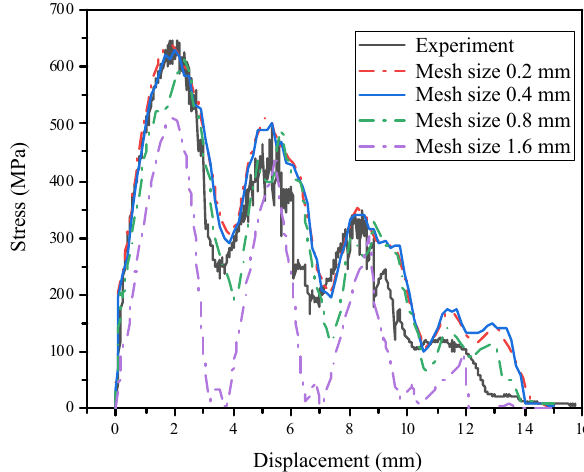
Figure 8: Convergence of stress response with respect to element sizes.